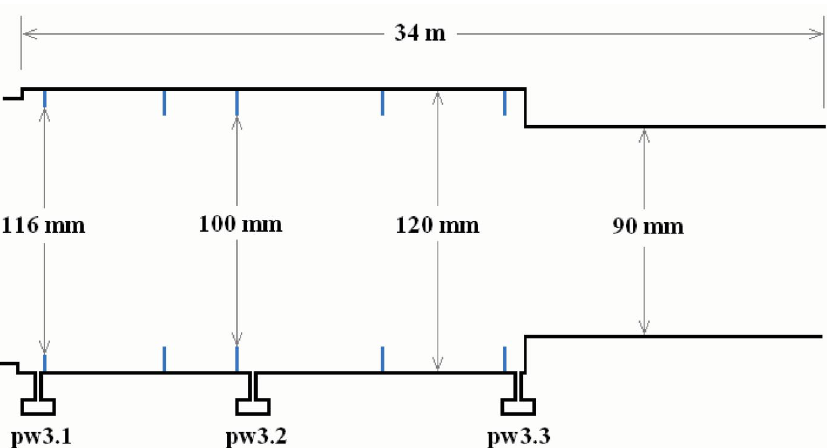
FIG. 2. (Color) Schematic diagram of the Q3–Q4 Yo5 warm section where the antigrazing rings were installed. The longitudinal locations and internal diameters of the stainless steel rings and vacuum pipes are indicated. The horizontal and vertical scales differ by a factor 100. The locations of the rings were determined by practical considerations related to the locations of existing vacuum-tube flanges, and their internal diameters were dictated by concerns against significantly limiting the physical aperture. The labels ‘‘pw3’’ indicate the locations of the vacuum gauges used. Pumping stations are also located at these locations.